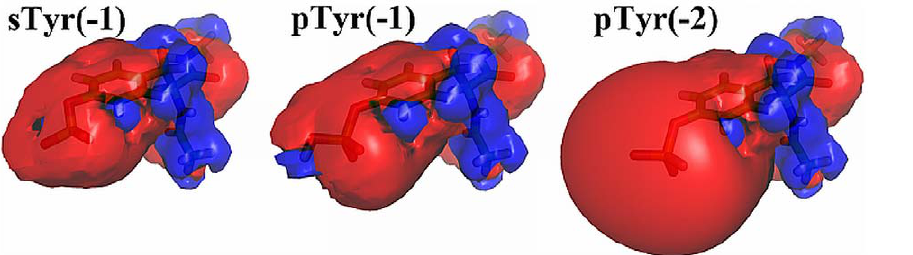
Figure 4. A comparison of electrostatic potentials for sTyr, pTyr( 2 1), and pTyr( 2 2). Electrostatic potentials are shown at isosurfaces of + / 2 2 kTe. The protonated phosphate group of pTyr( 2 1) presents a shaped charge that can provide a stronger interaction with hydrogen bond donors than the more isotropic charge on the sTyr sulfate.